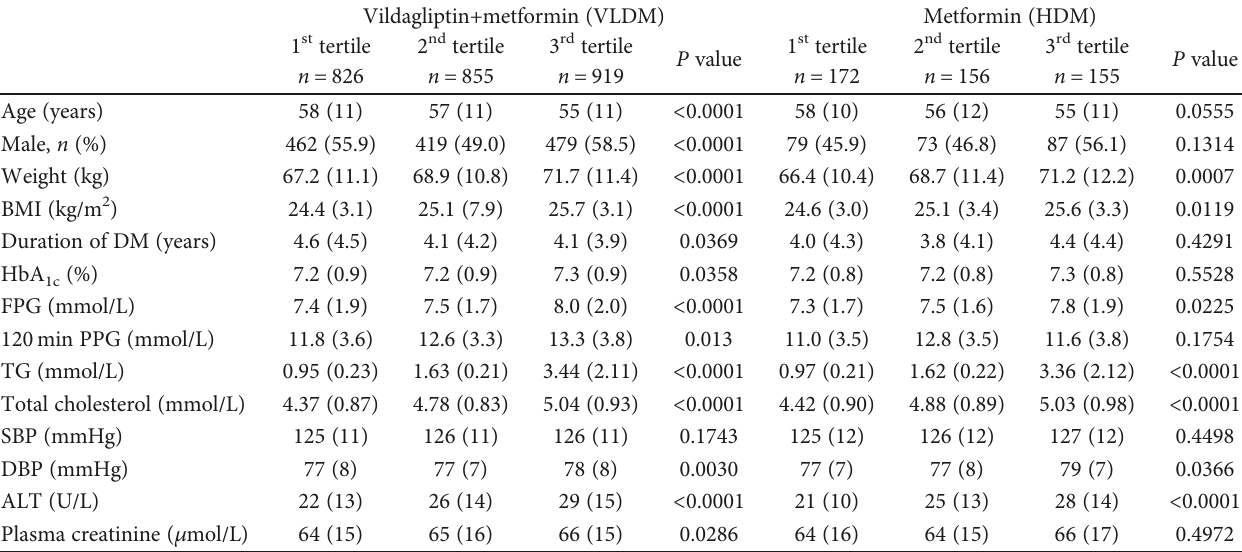
Table 1: Patients ’ baseline demographics and clinical characteristics (FAS) according to the 3 TG-based tertiles. Vildagliptin+metformin (VLDM) Metformin (HDM)